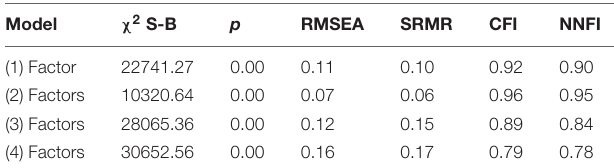
TABLE 1 | Fitting indexes of the scale with different factorial answers.